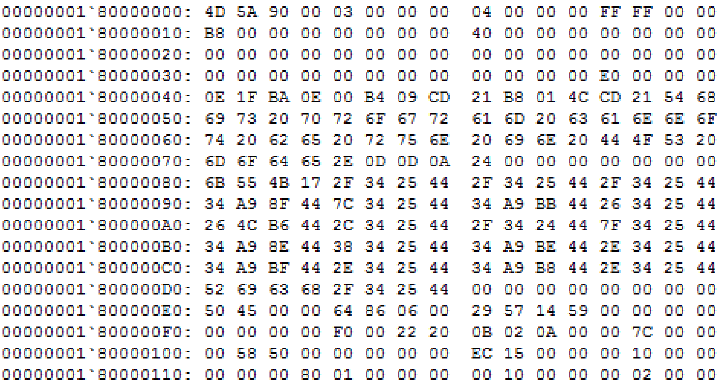
Figure 1. The structure of a binary file.